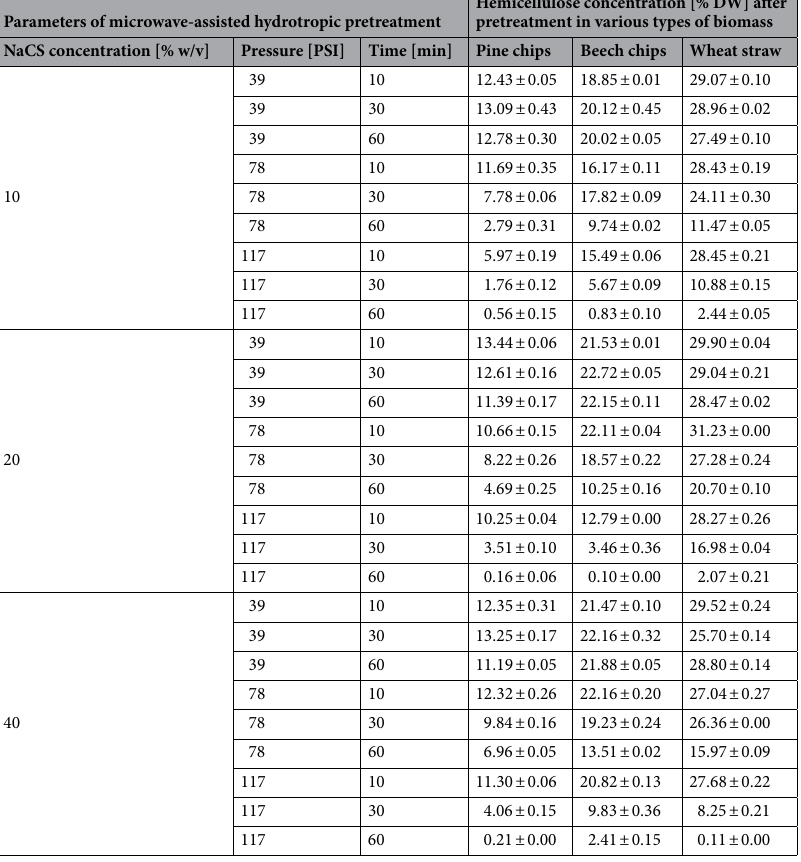
Table 2. Hemicellulose concentration in various types of biomass after microwave-assisted hydrotropic